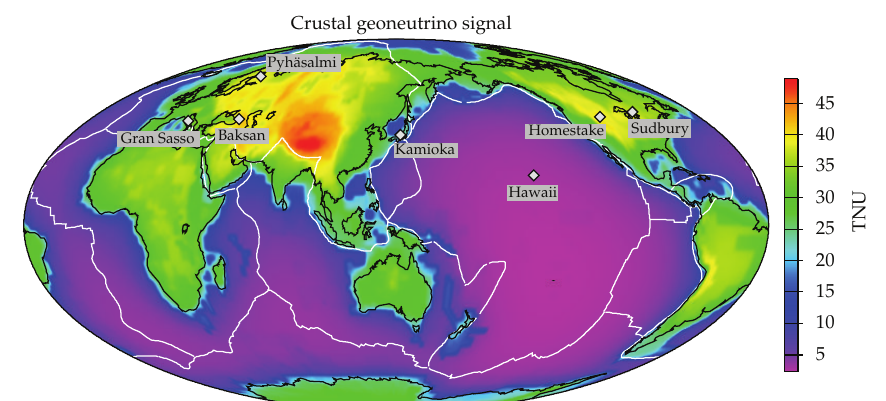
Figure 8: Global map of crustal geoneutrino signal (cid:5) U (cid:7) Th (cid:6) in TNU. Prediction is based on CRUST2.0 crustal structure and HPE abundances listed in Table 7. Continental outlines (cid:5) black (cid:6) , plate boundaries (cid:5) white (cid:6) , and locations of geoneutrino detectors are plotted. Mollweide equal-area projection was used. See (cid:3) 69 (cid:4)